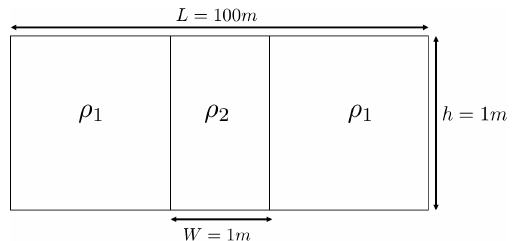
Figure B3. Initial state of the density-driven dam break (Leighton et al.,